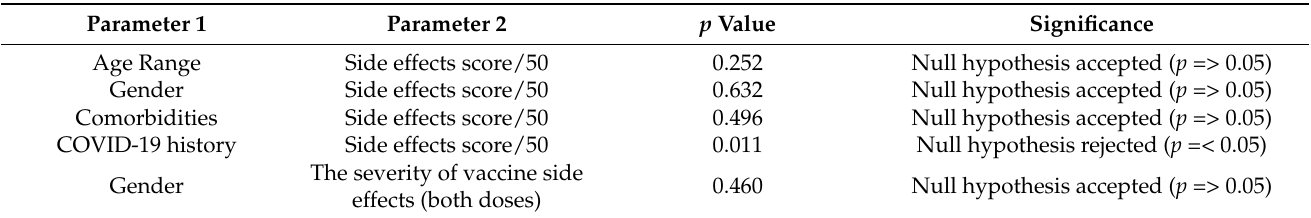
Table 4. Summary of the association/significance of the correlation between different